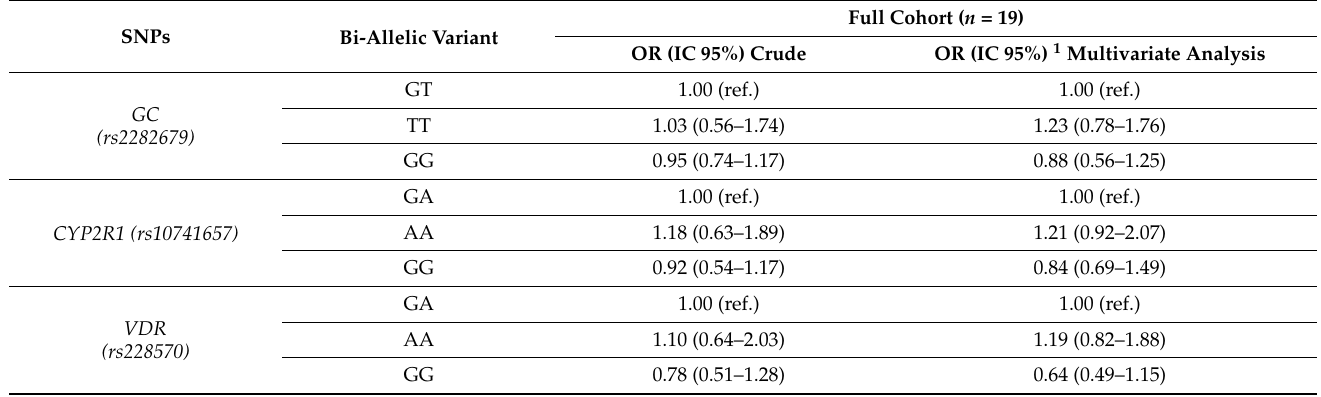
Table 6. Participant study characteristics and single nucleotide polymorphisms (SNPs) associated with 25-hydroxy vitamin D concentration. Crude and adjusted Multivariate logistic regression models with corresponding Odds Ratio (OR) and 95% Confidence Intervals (95%